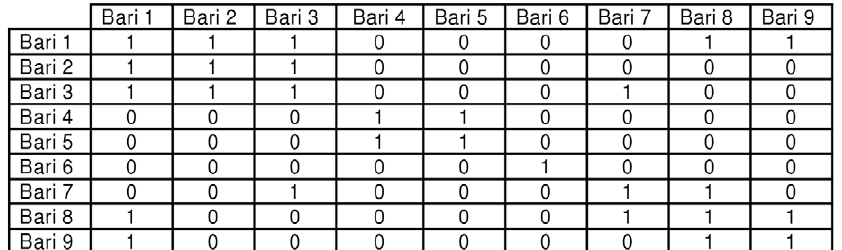
Figure 1. Matrix network example of bari -level kinship social connections. GREY circles indicate baris while RED lines indicate a kinship- based social connection between the two linked baris .